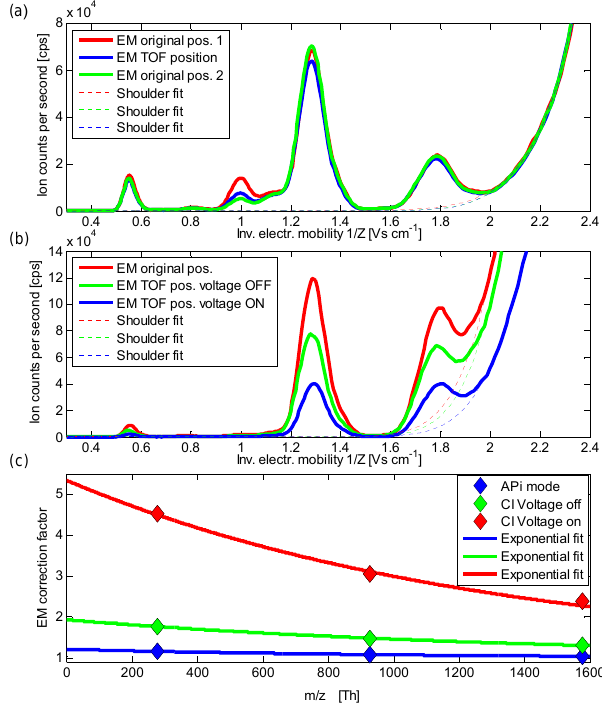
Figure 2. (a) Mobility spectrum for MTOA generated by the HR- DMA with the EM at original position and when its position was in- terchanged with that of the APi-TOF. The shoulder on the right orig- inates from multiply charged higher clusters. The fit of the shoul- der to correct the trimer concentration is shown as well. (b) Same as (a) but with two nylon insulators and potential step of − 500V added to the setup. Applying the voltage results in additional dras- tic losses. (c) Calculated correction factors for MTOA monomer, dimer, and trimer and exponential fit for extension to smaller m/z